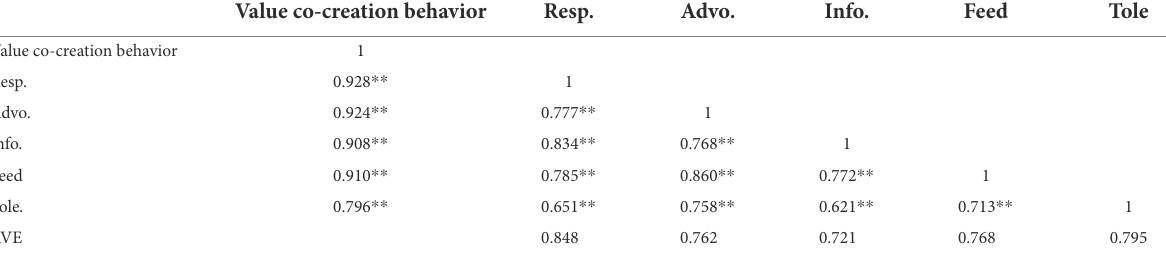
TABLE 3 Correlation matrix of five sub-dimensions of value co-creation behavior. Value co-creation behavior